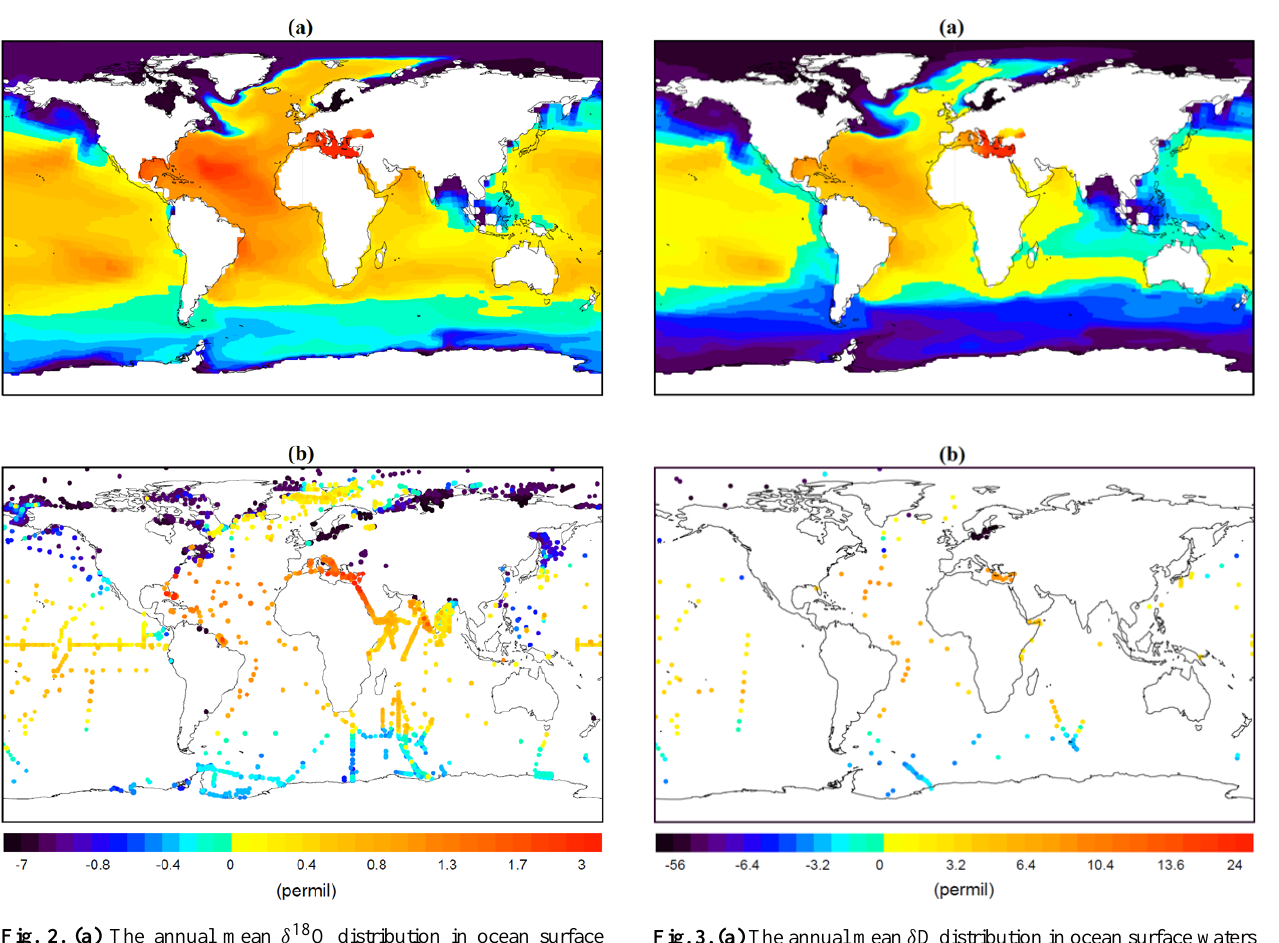
Fig. 3. (a) The annual mean δ D distribution in ocean surface waters as simulated by MPI-OM. (b) Available δ D measurements from sea surface water samples (see text for details).